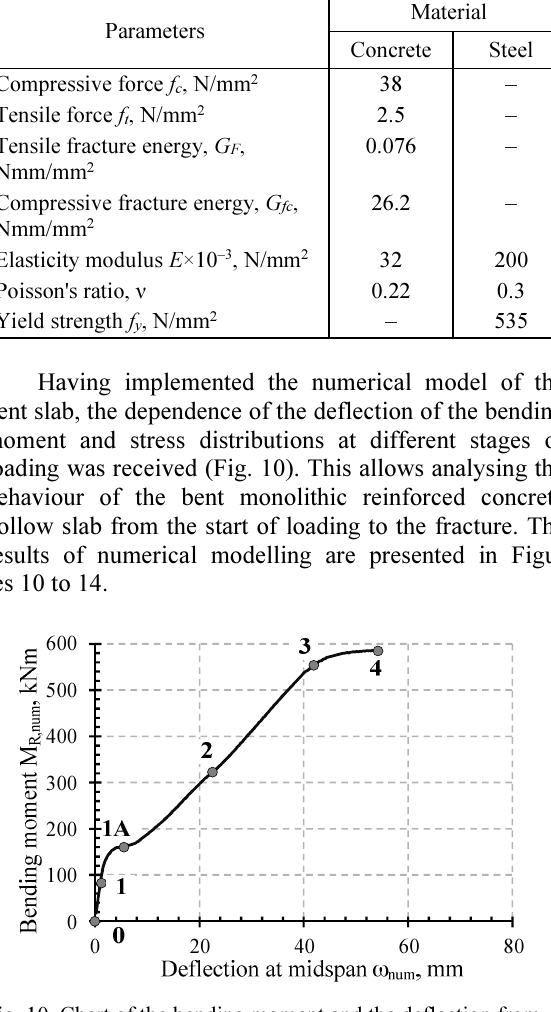
Fig. 10. Chart of the bending moment and the deflection from numerical modelling